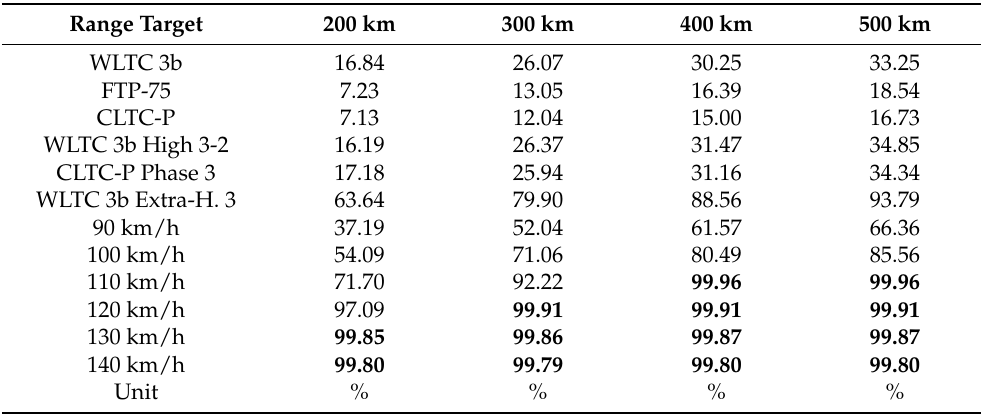
Table 15. REX utilization measures the share of total driving time when REX is enabled. Bolded values indicate that REX is engaged once and working constantly, and a range target cannot be obtained. Vehicle mass equals 1500 kg.